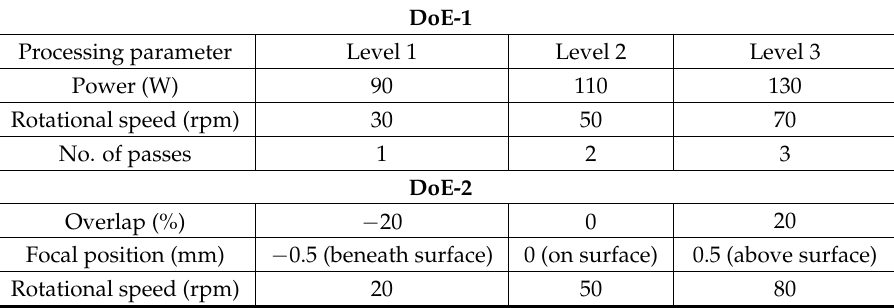
Table 2. The laser processing parameters implemented for design of experiment (DoE) model 1 and 2, both according to the Box Behnken model.